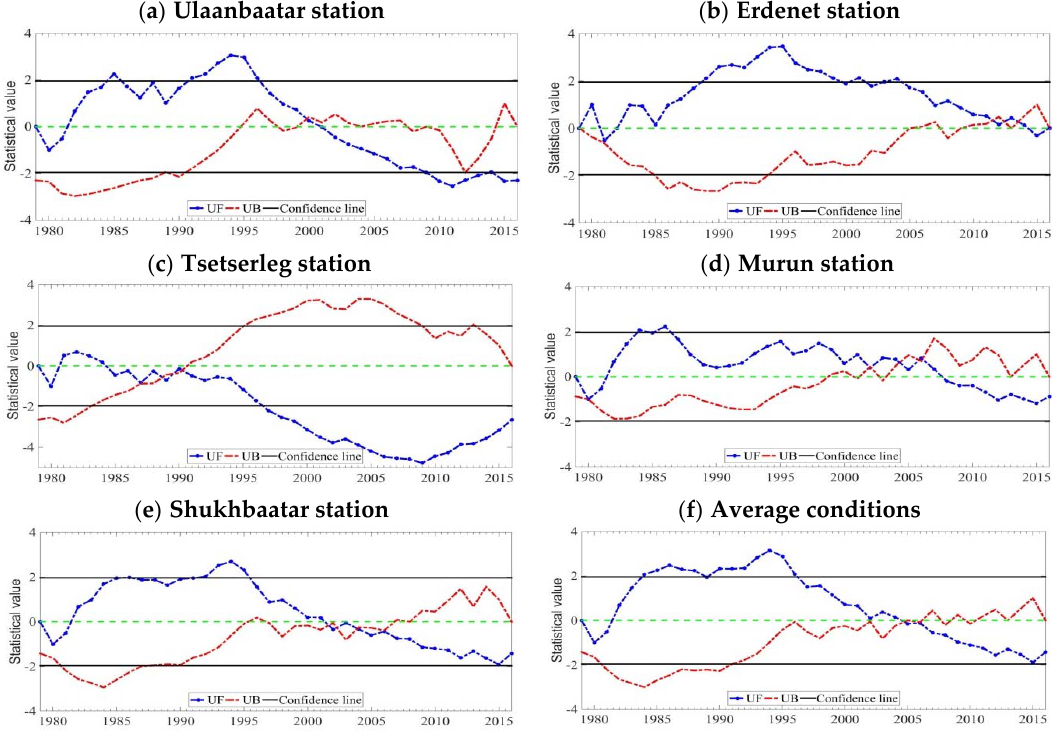
Figure 5. Trends of annual discharge across stations (note: UF and UB are changing parameters where UB = − UF).